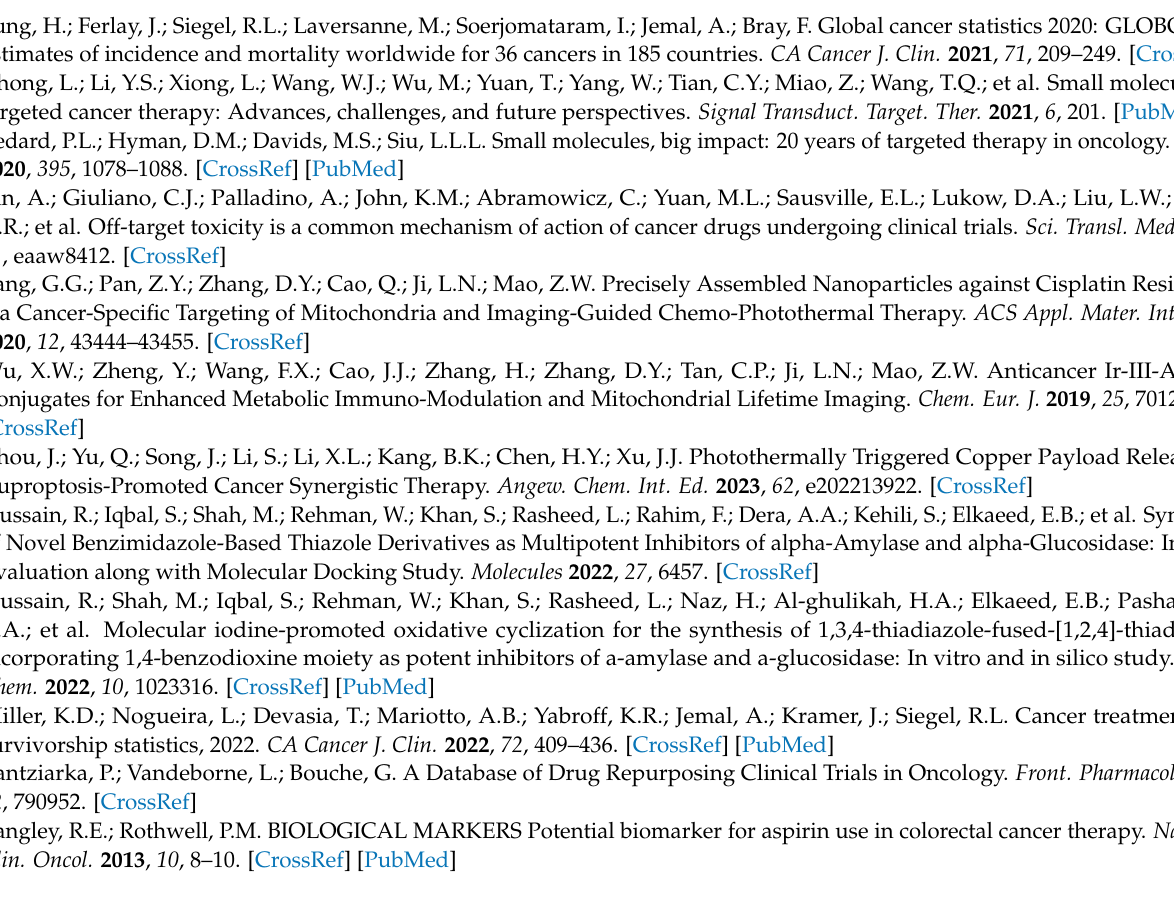
Figure S3: In vitro reactive oxygen species generation by MS-Cu and PEG-MS-Cu nanospheres; Figure S4: The particle size of PEG-MS-Cu nanospheres tested by dynamic light scattering analysis immediately (left) and 3d (right) after ultrasonication; Figure S5: In vivo distribution of PEG-MS-Cu nanospheres; Figure S6: Hemolysis of PEG-MS-Cu